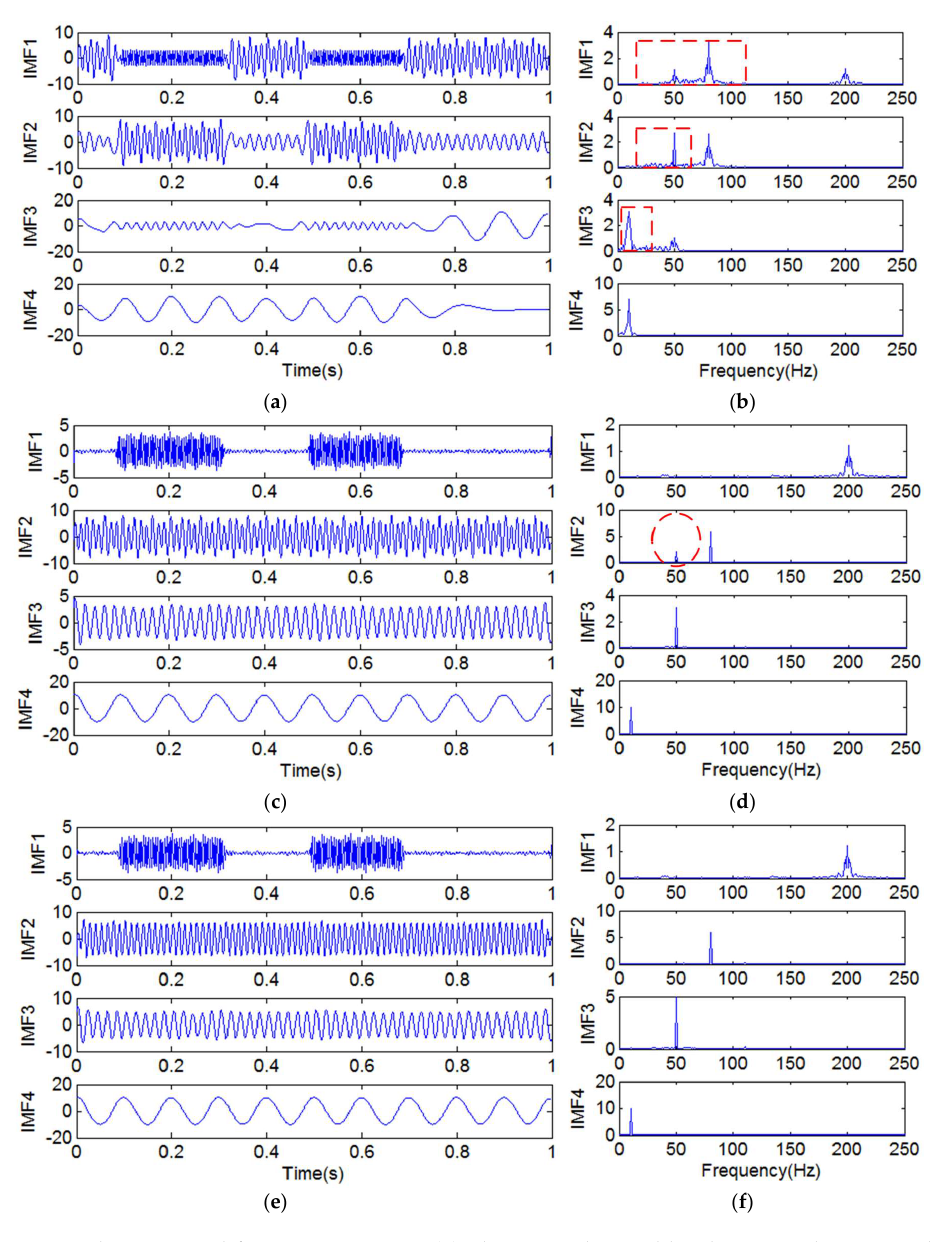
Figure 19. The IMFs and frequency spectra. ( a ) The IMFs obtained by the original EMD method; ( b ) the frequency spectrum corresponding to each IMF in ( a ); ( c ) the IMFs obtained by only adding a high-frequency sinusoidal signal y 16 ( t ); ( d ) the frequency spectrum corresponding to each IMF in ( c ); ( e ) the IMFs obtained by adding a high-frequency sinusoidal signal y 16 ( t ) and embedding a decorrelation operator; ( f ) the frequency spectrum corresponding to each IMF in ( e